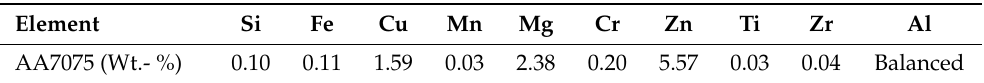
Table 1. Chemical composition of investigated AA7075 alloy experimentally determined using optical emission spectroscopy (OES).